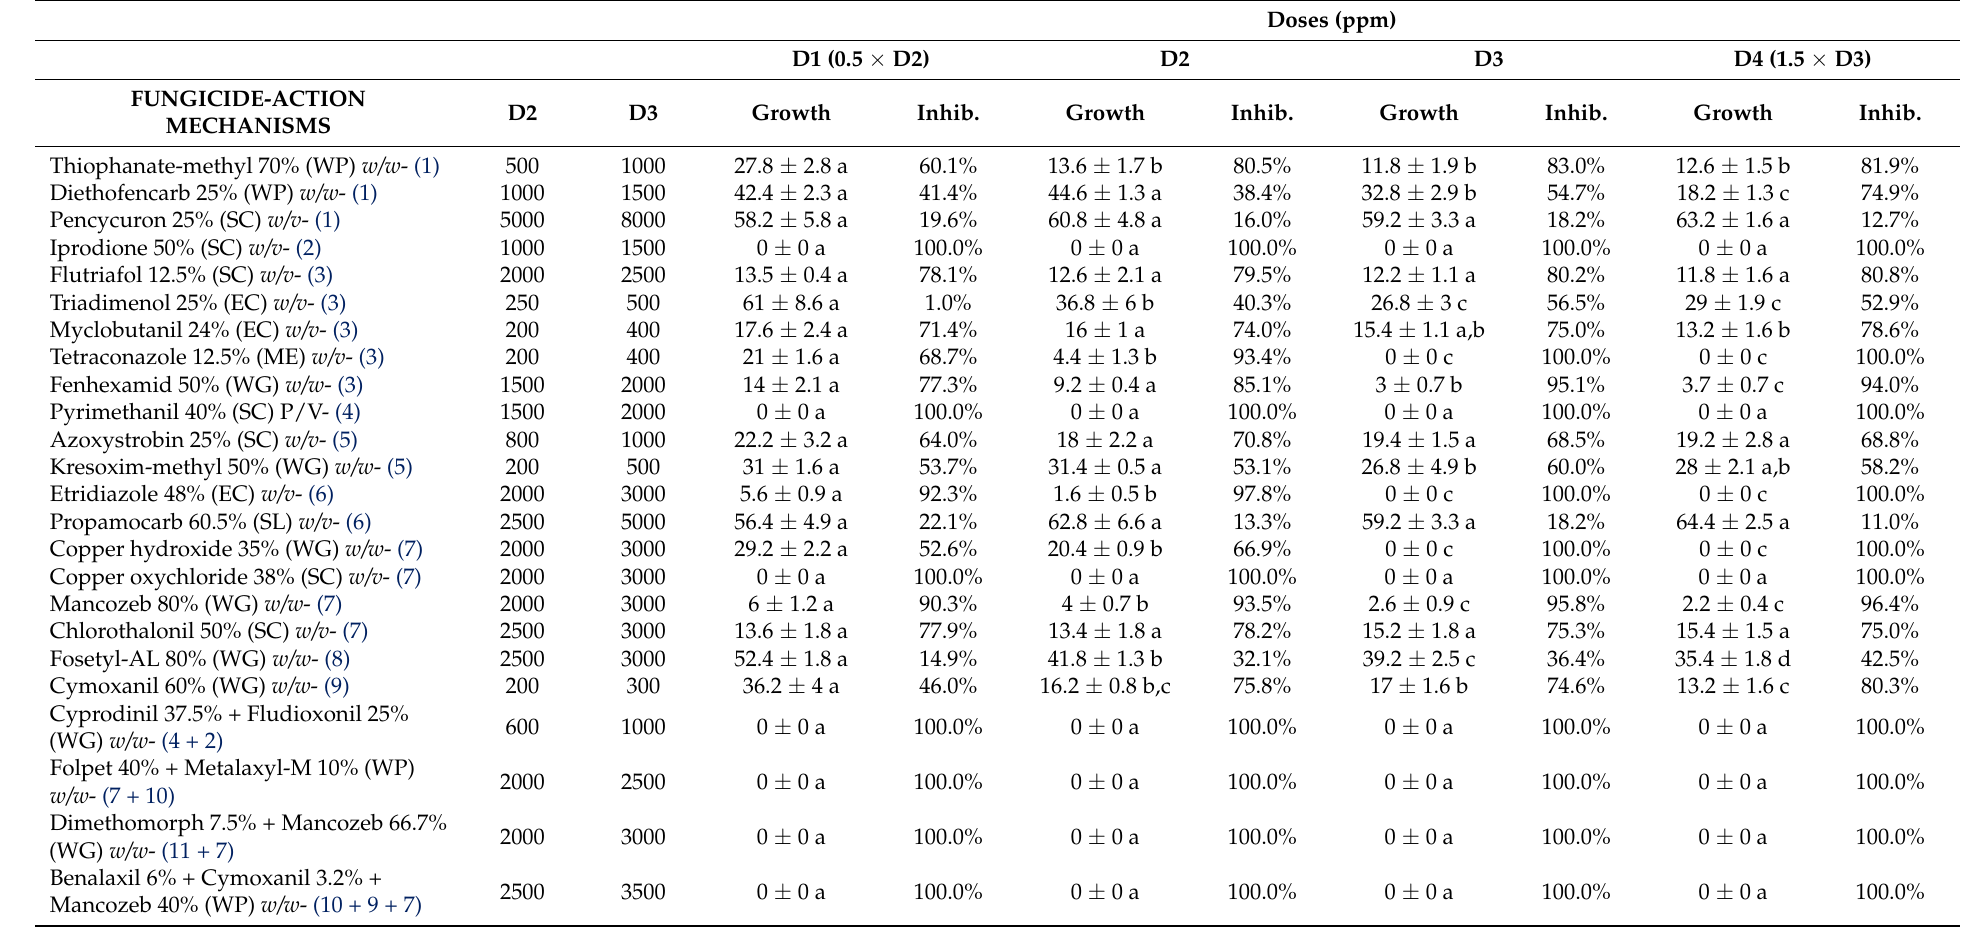
Table 1. Effect of different fungicides on mycelial growth of P. variotii at different doses (D1-D4). Mean values ( ± standard deviation) followed by different letters (line) indicate significant differences ( p < 0.05) by the least significant difference test (LSD). Fungicide action mechanisms (blue numbers): (1) Cytoskeleton and motor proteins, (2) Signal transduction, (3) Sterol biosynthesis in membranas, (4) Amino acids and protein synthesis, (5) Respiration, (6) Lipid synthesis or transport / membrane integrity or function, (7) Chemicals with multi-site